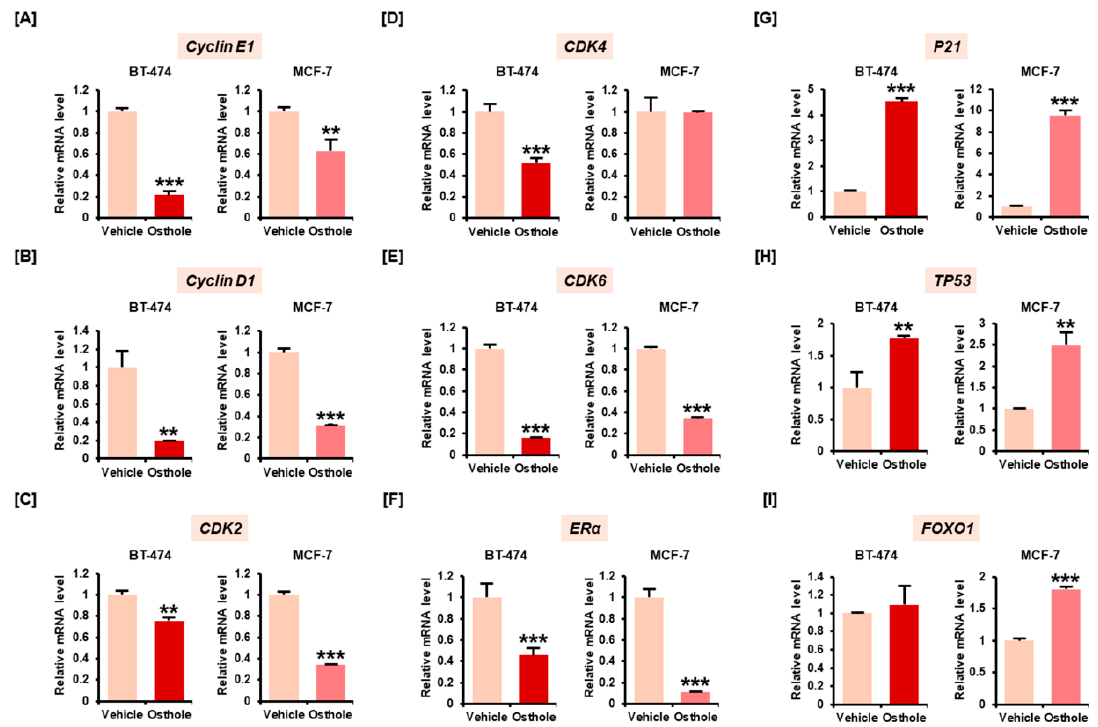
Figure 2. Relative mRNA expression of cell cycle-related genes including cyclin E1 ( A ), cyclin D1 ( B ), CDK2 ( C ), CDK4 ( D ), CDK6 ( E ), ER α ( F ), P21 ( G ), TP53 ( H ), and FOXO1 ( I ) . Expression of cell cycle- related genes in breast cancer cell lines was analyzed by quantitative RT-PCR using cDNA templates based on RNA isolated from BT-474 and MCF-7 cells. The graphs indicate the relative mRNA expression in breast cancer cell lines treated with vehicle and osthole for 24 h. All experiments were performed in technical triplicate and the asterisks represent statistically significant differences compared to vehicle-treated cells (** p < 0.01 and *** p < 0.001).